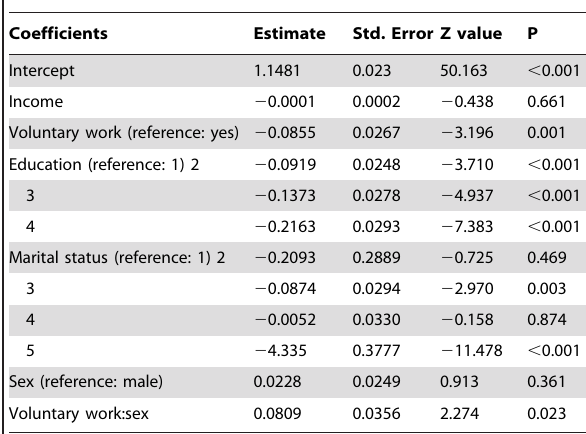
Table 1. Generalized linear model of sex, voluntary work, marital status, education, and income on offspring number on the basis of a Poisson error